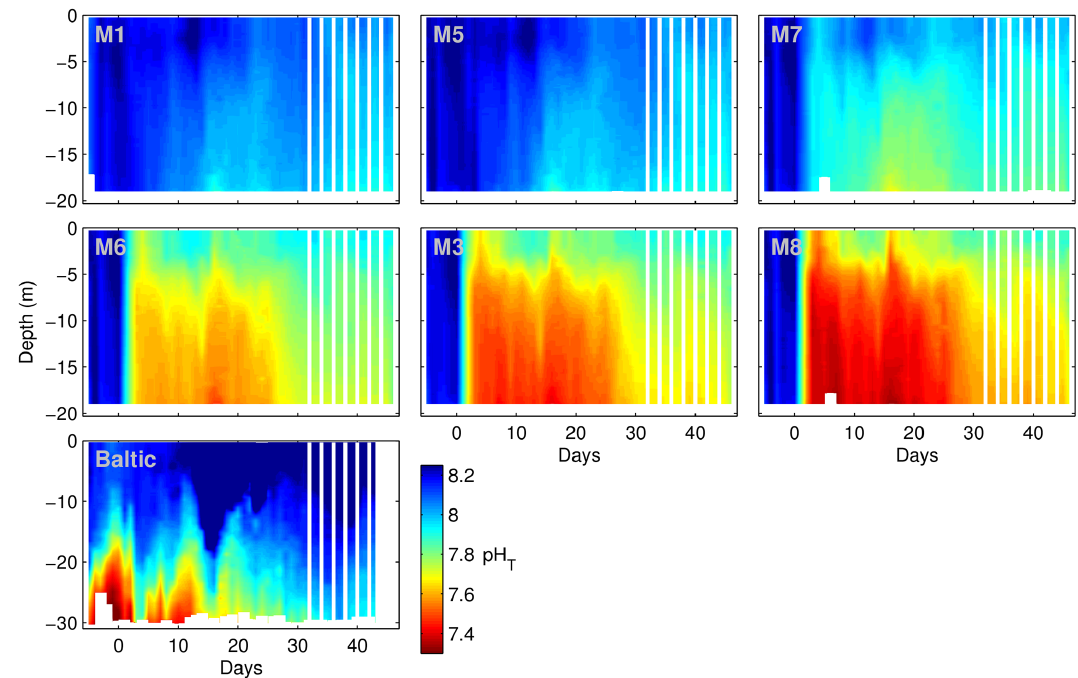
Figure 8. Vertical pH T profiles taken using a pH sensor on a hand-operated CTD during the experiment in the mesocosms and in the surrounding water, here named “Baltic”. For details of CTD operations and pH T calculations, see Sect. 2.5.1. White vertical lines indicate CTD profiles were taken every second day after t 31.